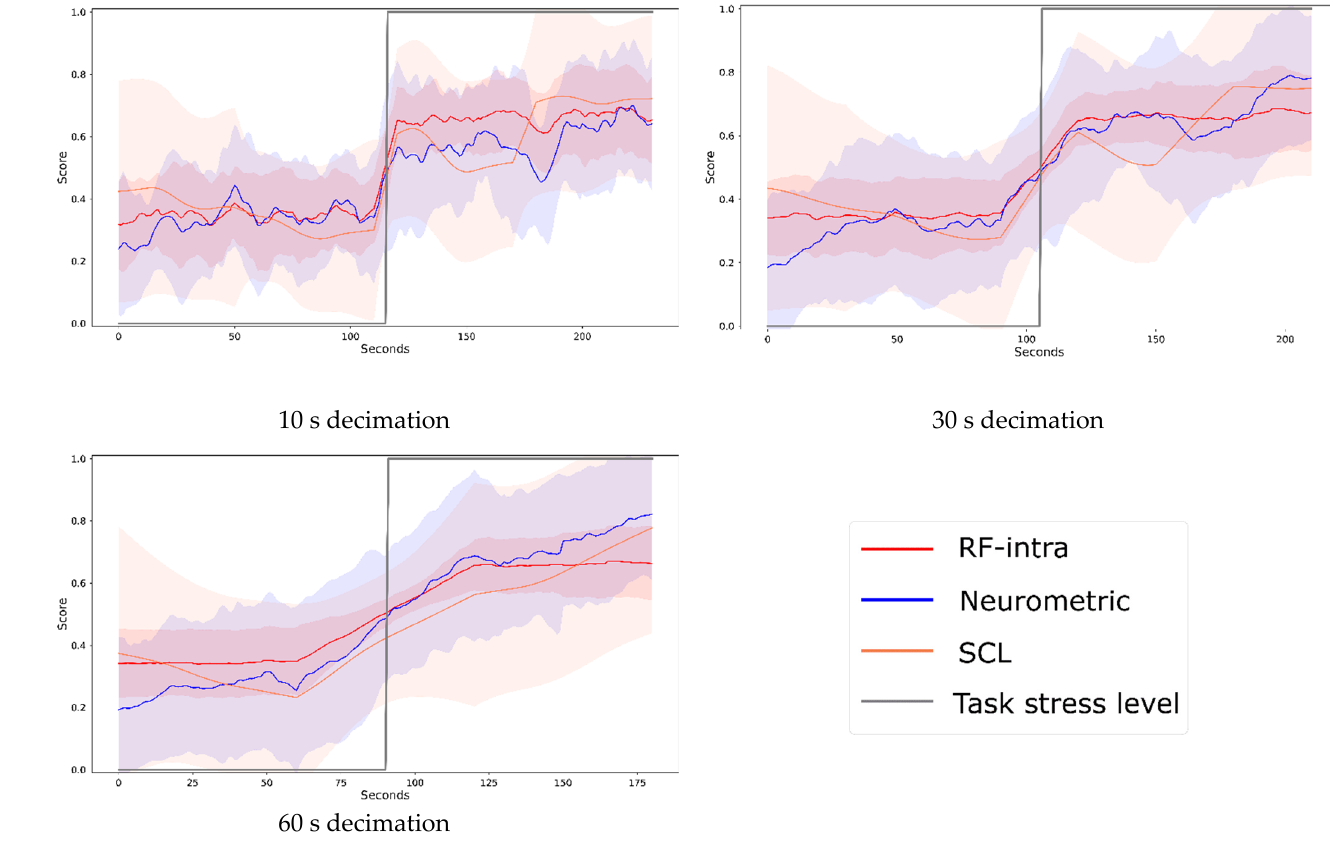
Figure 5. Stress during the multitasking experiment. The time series were obtained from the three different models at three different decimations (10, 30 and 60 s). The line represents the average over the population of recorded stress value, the shadow represents the standard deviation. In grey the expected value of stress level (low- and high-stress conditions) is represented, the Random Forest (RF-intra) is represented in red, the Neurometric in blue, and the Skin Conductance Level (SCL) in orange. Table 2. Values of Pearson correlation (R) and the distance between curves computed in terms of Root mean squared error (RMSE) for the multitasking experiment. The median and interquartile range (IQR) have been reported.